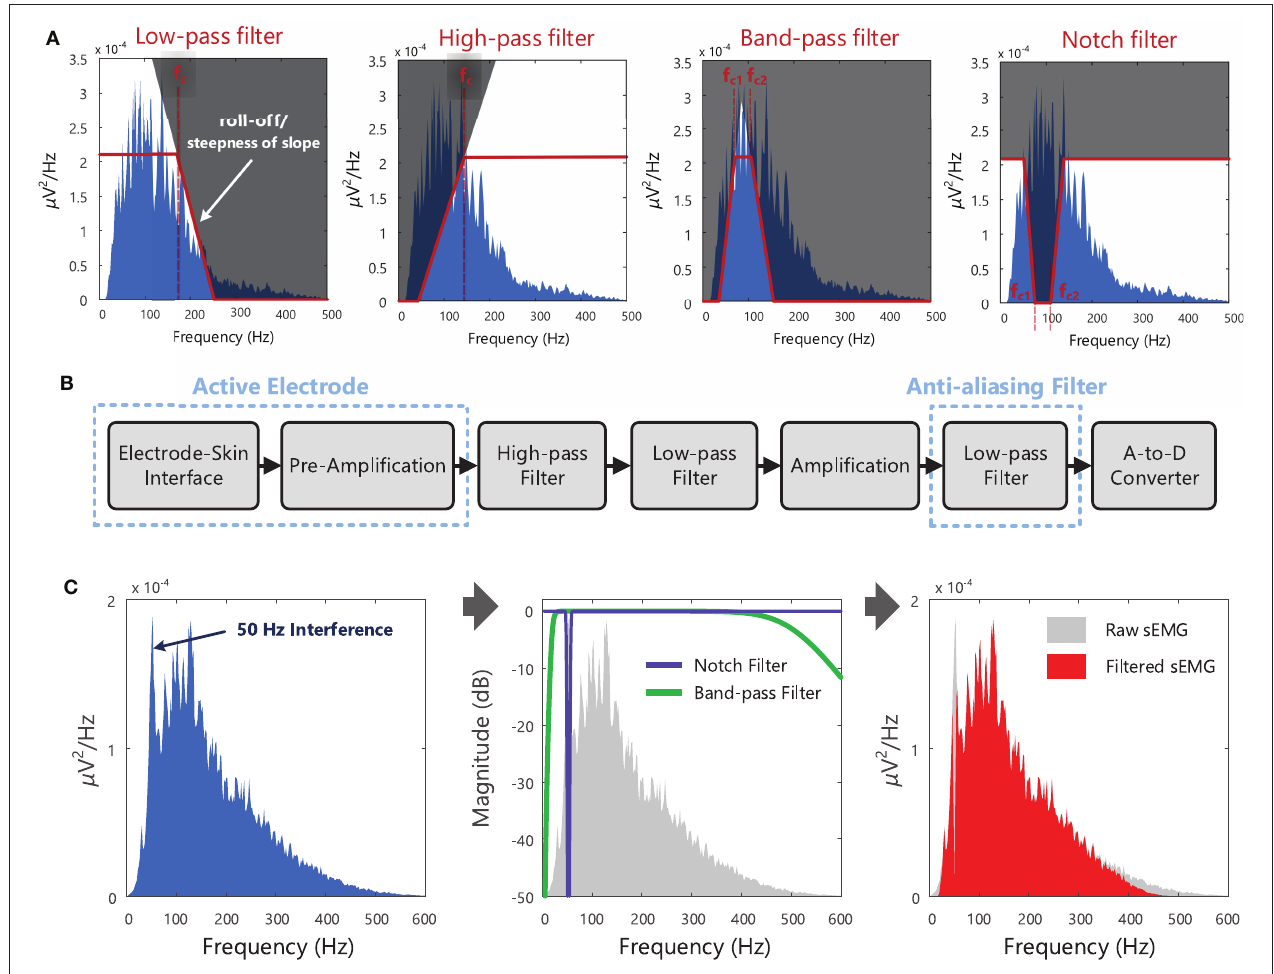
FIGURE 10 | (A) Different types of filters that can be used to shape the EMG spectrum, to keep, remove, or attenuate certain frequency components of the EMG signal + noise. In the example shown, the low-pass filter has a cut-off frequency (f c ) of 170Hz and the high-pass filter has a cut-off frequency of 140Hz. The band-pass and notch filters have lower cut-off frequencies (f c1 ) of 70Hz and upper cut-off frequencies (f c2 ) of 108Hz. (B) Schematic of the typical stages in recording surface EMG signals, with filtering at several points along the process (filters that operate on the analog signal, i.e., hardware filters). With active electrodes, pre-amplification is performed within the electrode itself (rather than the amplification being performed in an external circuit), see section Choice of Amplifier. EMG signals are low-pass filtered before sampling to suppress high-frequency components and prevent the distortion of the spectral content, see Figure 8 . See Examples (ix) and (x) in Tutorial Code. (C) An example of a noisy sEMG signal contaminated with 50Hz interference, the frequency response of a 50Hz notch filter and a 20–500Hz band-pass filter (the figure indicates how much the sEMG signal is attenuated by the filter, in dB, at each frequency), and filtered sEMG spectrum (after notch and band-pass filtering the raw sEMG signal). Note that notch filters are typically used when only an approximate estimate of EMG amplitude is